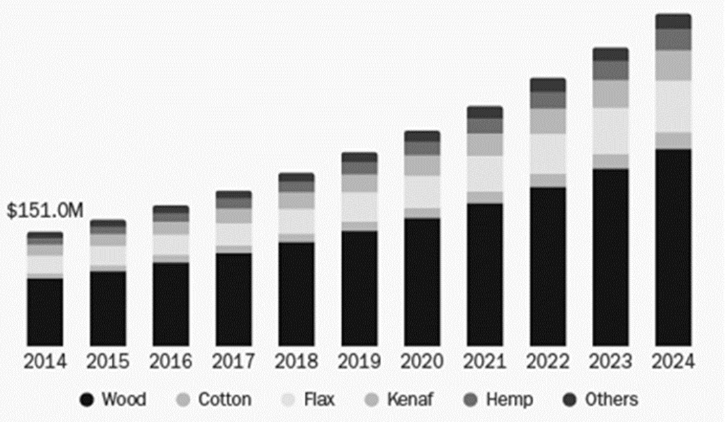
Figure 3. Natural fibres market for composites in 2014–2024 (USD million) [40].